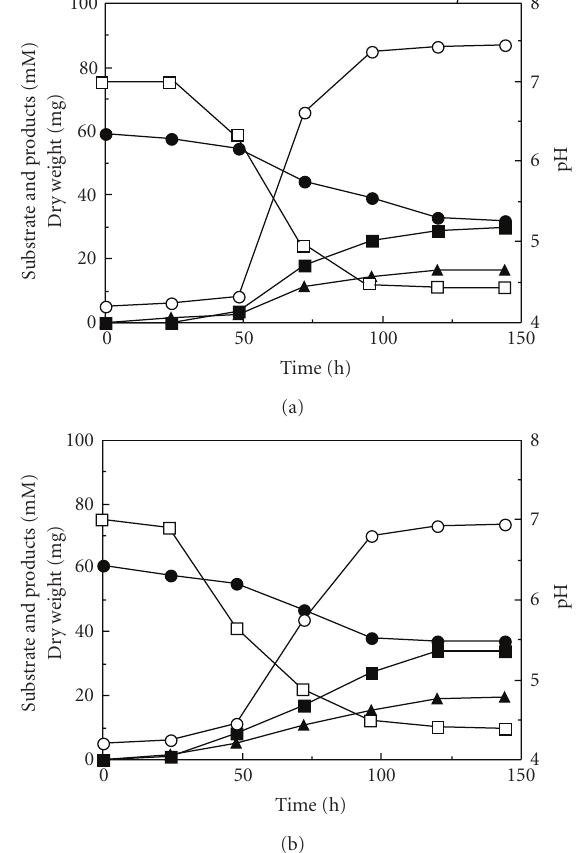
Figure 4: Growth of RB-1 in both aerobic (a) and anaerobic mediums (b). RB-1 was grown on glucose in basal medium with 1% glucose as described in Section 2. Symbols: ( ) glucose; ( (cid:2) ) acetate; ( (cid:3) ) ethanol; ( (cid:5) ) dry weight; and ( (cid:4) ) pH. The data shown are from representative experiments of four independent experiments with similar